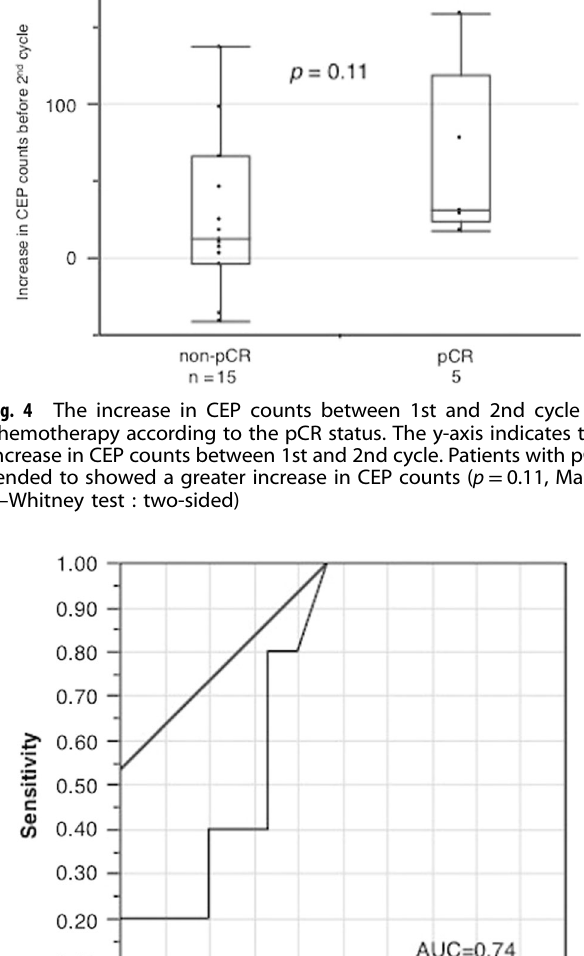
Table 3. Univariate and multivariate analysis of pCR (logistic